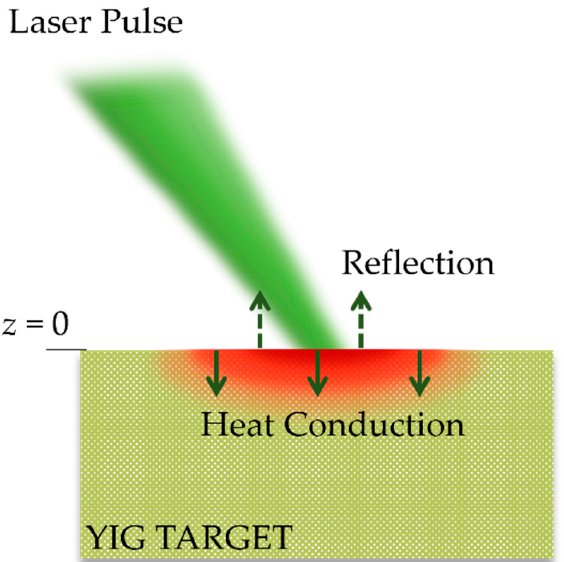
Figure 1. Schematic of laser irradiation of YIG target. The target surface is denoted by z = 0. The up and down arrows represent the laser energy that is reflected and absorbed by the target.